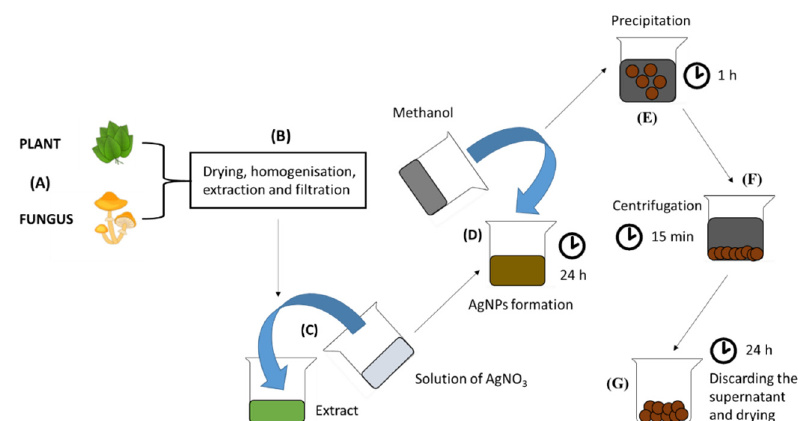
Figure 7. The process of preparation of AgNPs. ( A ) A plant / fungus is ( B ) homogenized, extracted, centrifugated and filtrated; subsequently ( C ), silver ions in the form of 0.1 M AgNO 3 are added in a 1:1 ( v / v ) ratio. ( D ) AgNPs are formed within 24 h. ( E ) AgNPs are precipitated with methanol in a 1:1 ( v / v ) ratio for 1 h. ( F ) The solution of AgNPs is centrifuged for 15 min, 4000 g . ( G )The supernatant is discarded and AgNPs are dried by lyophilization for 24 h.